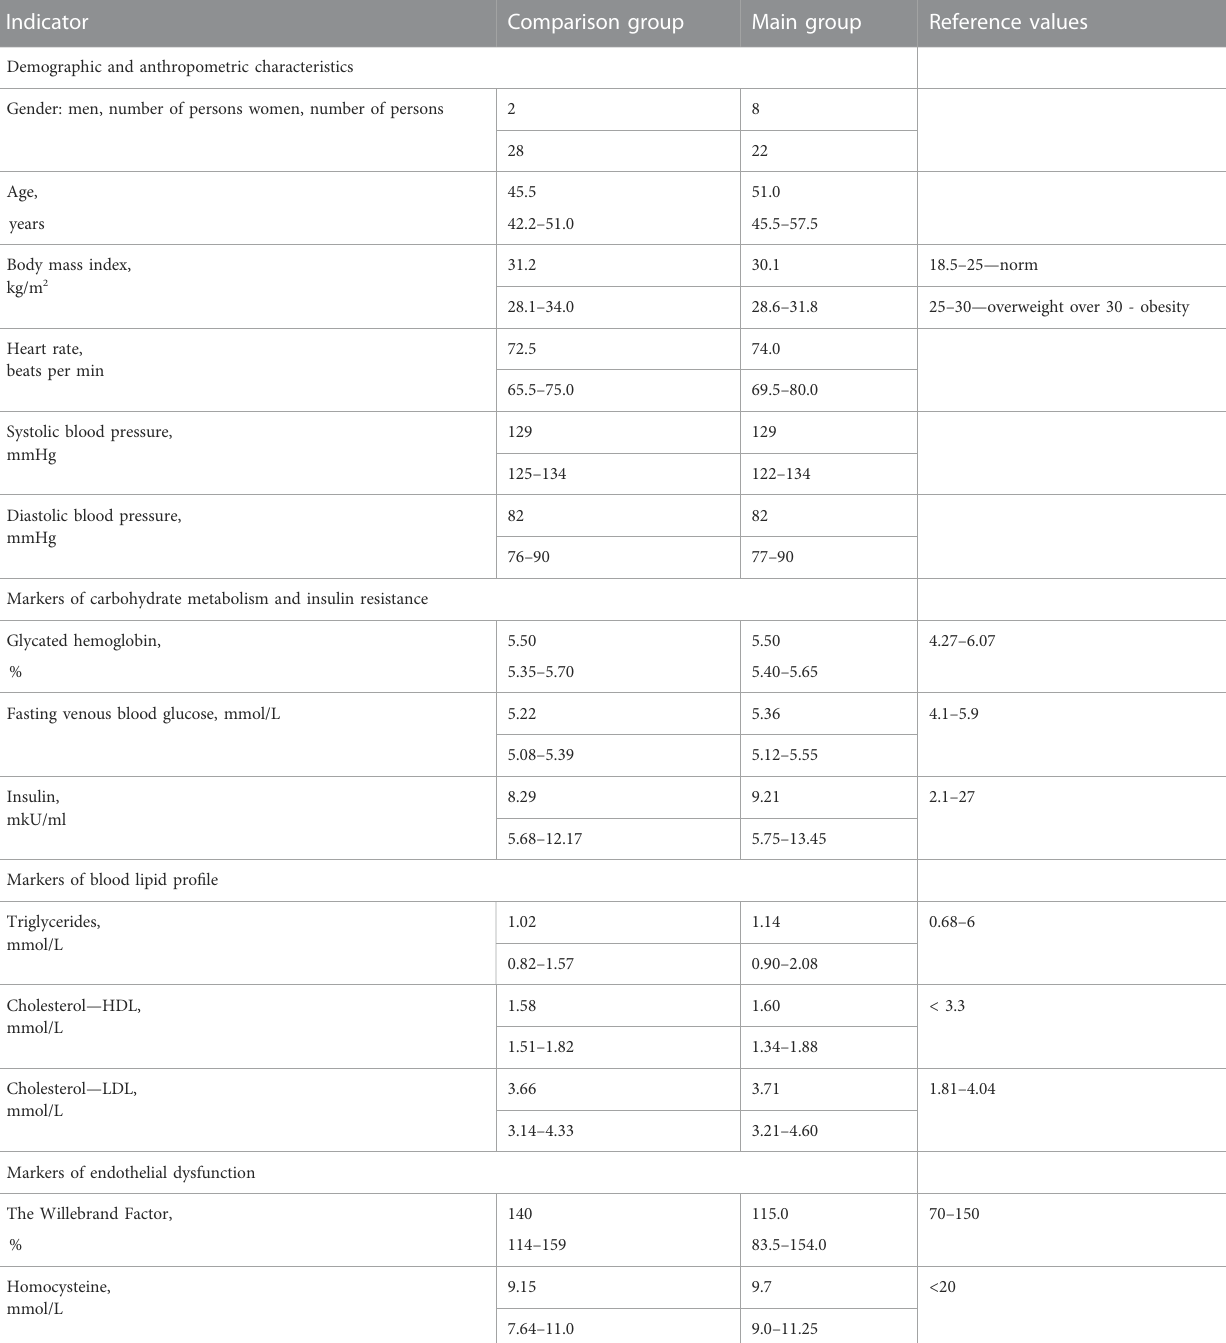
TABLE 1 Anthropometric and biochemical characteristics of patients from both groups.